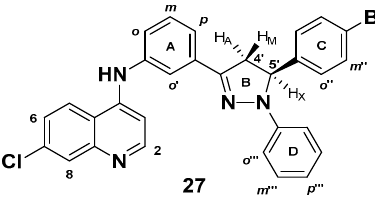
Figure 1. Structure of compound 27 showing the numbering of most carbons.